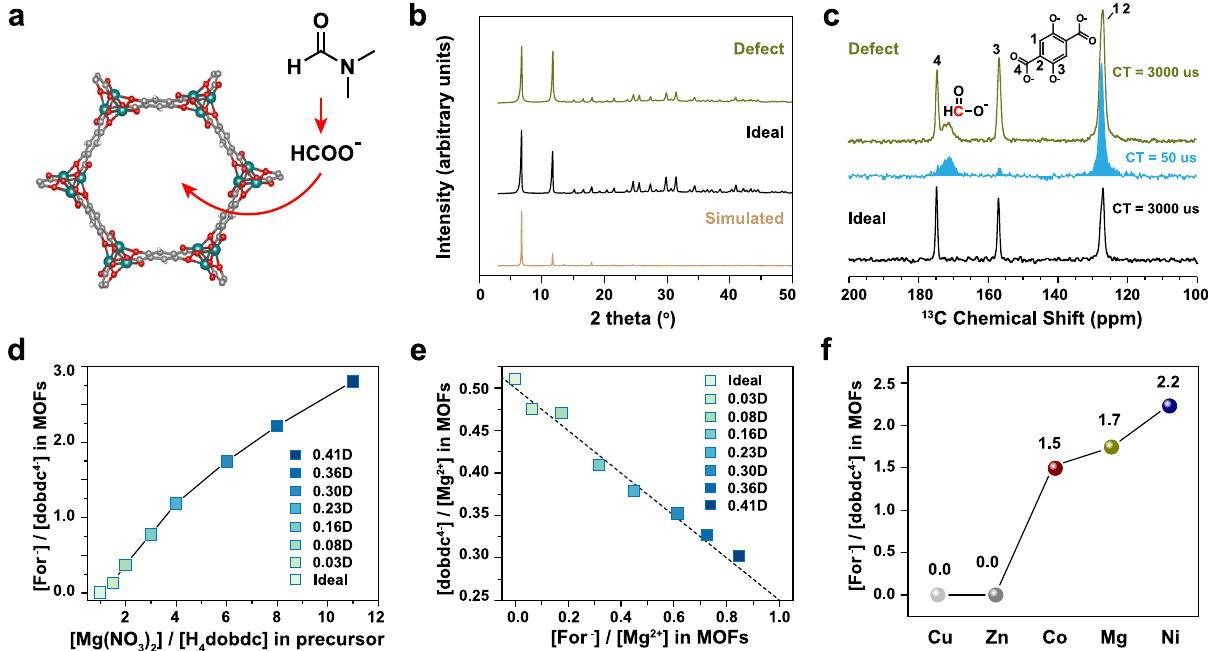
Fig.1|Theidenti fi cationofformatedefectsinMOF-74.a Schematicillustrations of the introduction of formate defects into MOF-74 from decomposed DMF. b PXRD patterns of the ideal sample and the defective 0.30D sample. c 13 C CPMAS spectra of ideal and defective MOF-74 with a short contact time (CT=50 μ